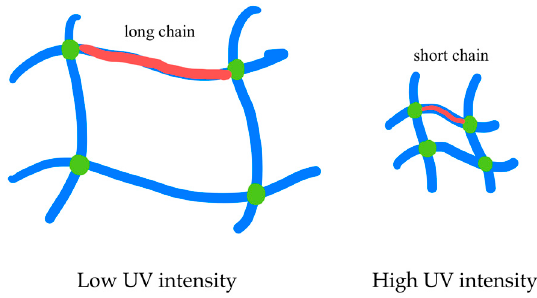
Figure 7. Effect of UV intensity on formation of network structure through photo-cationic polymerization.